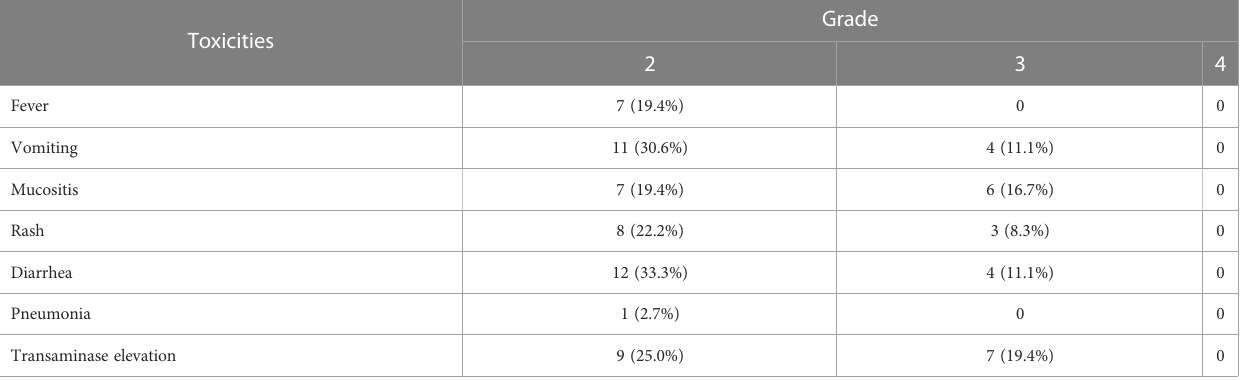
TABLE 3 Toxicities of grade 2-4 from ChiCGB.